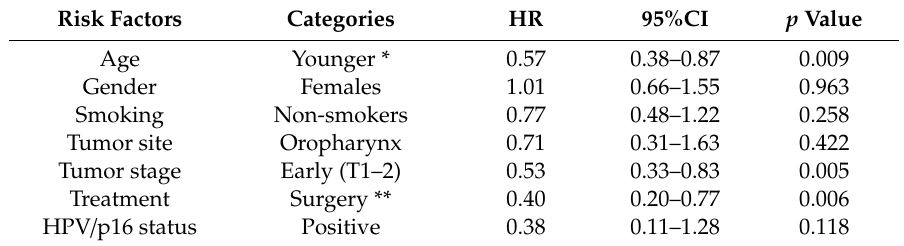
Table 2. Multivariate analysis using a Cox proportional hazard model to test the influence of various risk factors on overall survival in 285 patients with